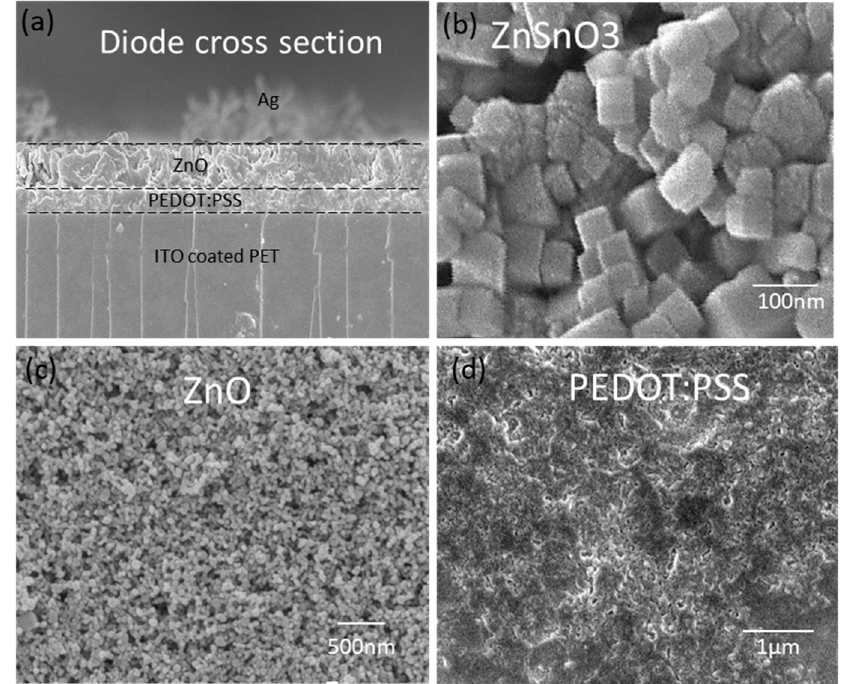
Figure 4. ( a ) Cross sectional view of the ITO/PEDOT:PSS/ZnO/Ag device. ( b ) Zinc stannate. ( c ) ZnO thin film SEM image. ( d ) PEDOT:PSS thin film SEM image.